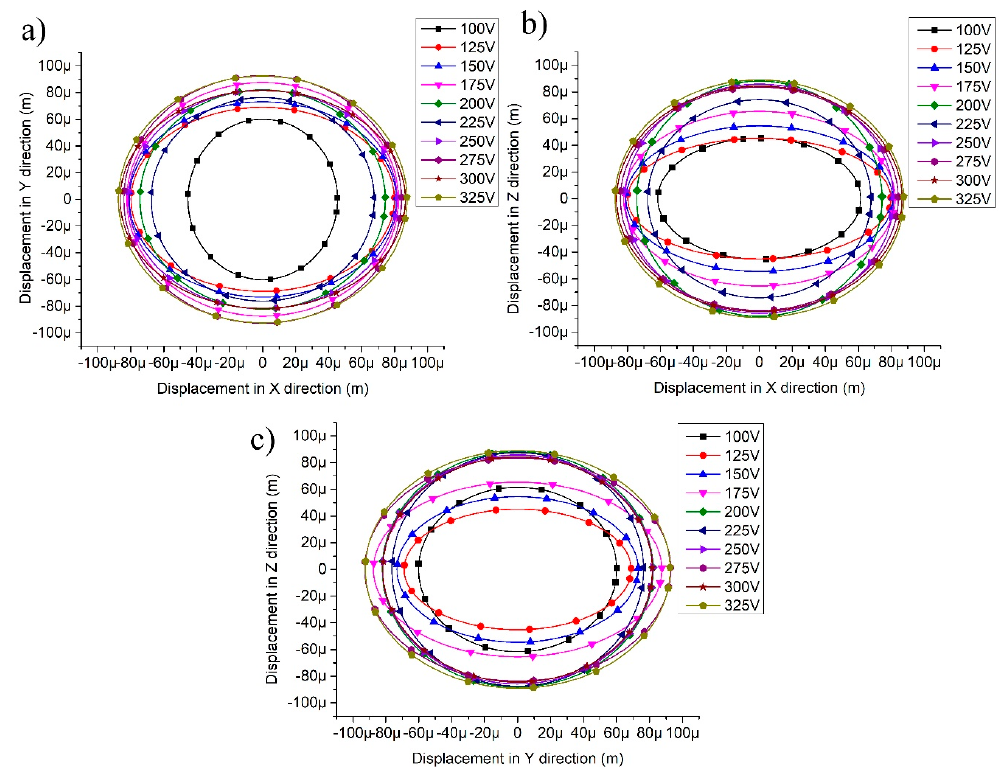
Figure 11. Trajectories of the contact point when different voltages are applied; ( a ) the trajectory of a contact point in the XY plane; ( b ) the trajectory of a contact point in the XZ plane; ( c ) the trajectory of a contact point in the YZ plane.